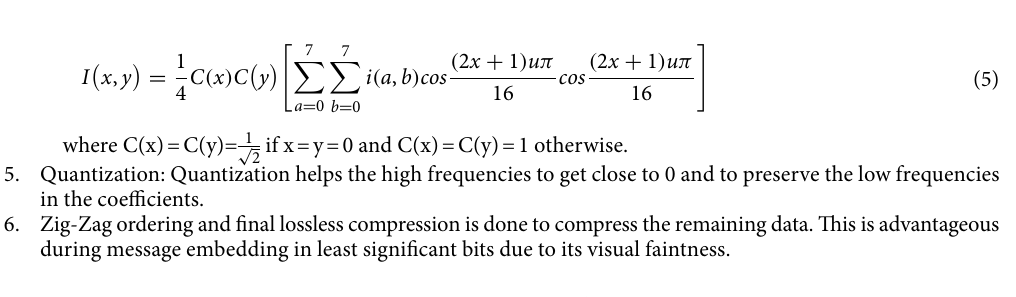
Figure 5. Block diagram of JPEG compression with lossy and lossless stages during the encoding